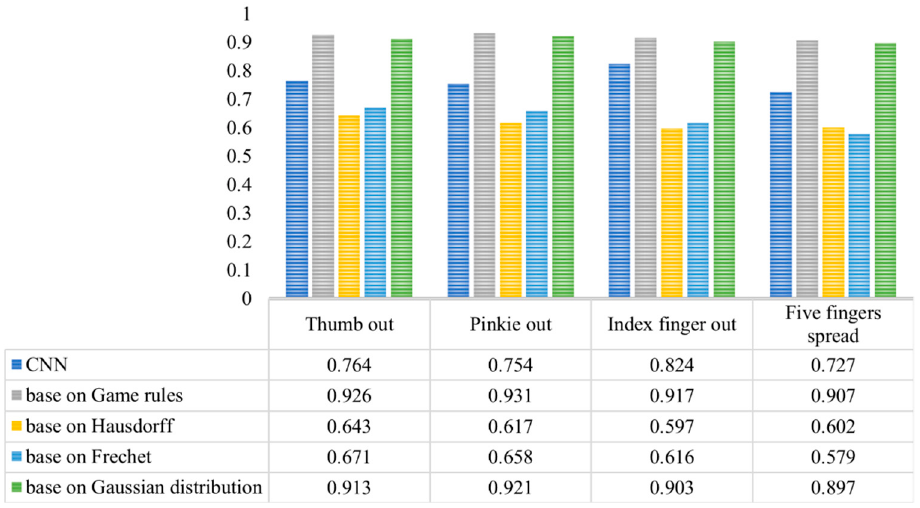
Figure 11. Comparison of recognition rates of different algorithms.